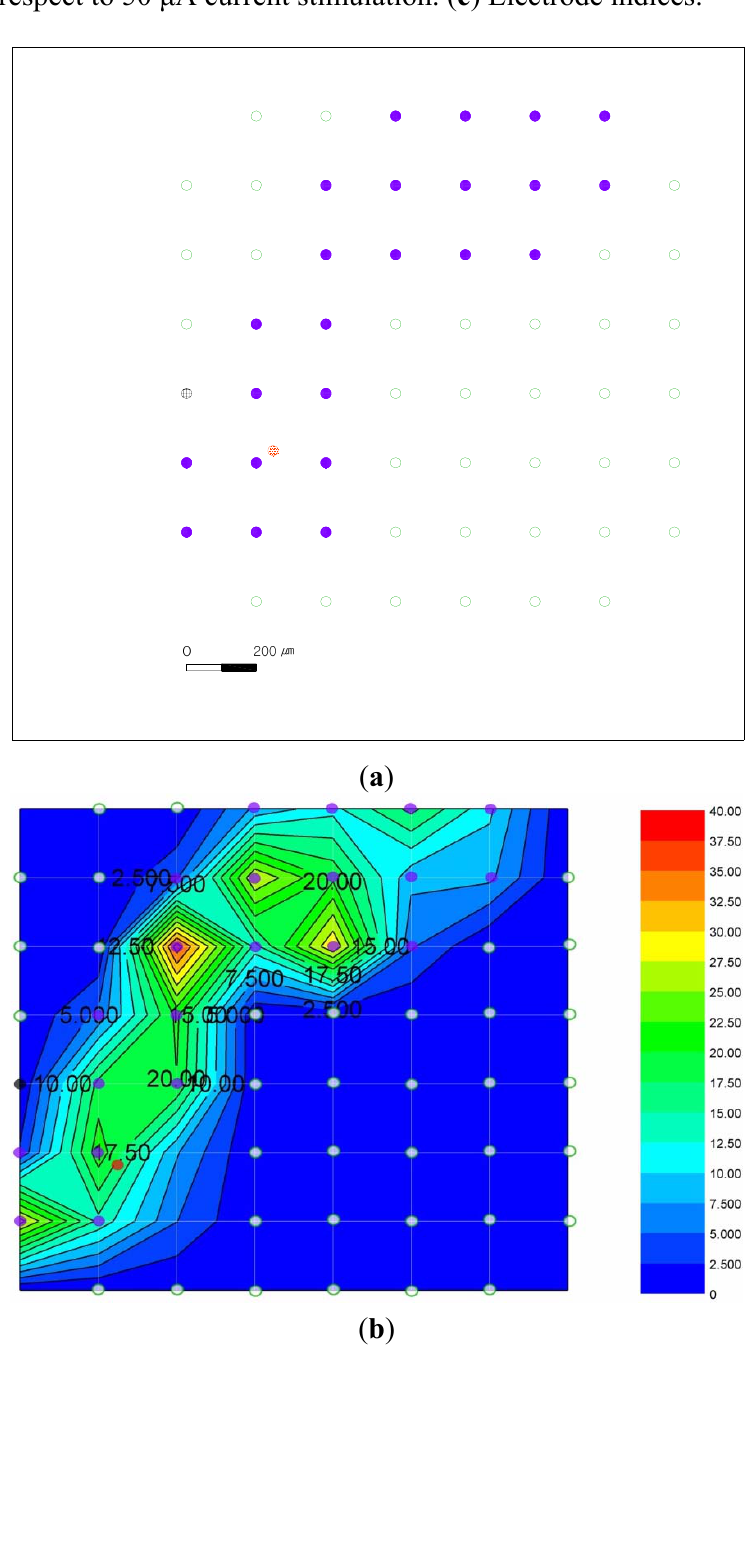
Figure 6. The monopolar stimulation results. ( a ) The spatial response map of the monopolar stimulation. ( b ) The contour diagram of the monopolar stimulation. The numbers on the contour diagram are the evoked RGC spike numbers with respect to 50 μ A current stimulation. ( c ) The spatial response map of the bipolar stimulation ( d ) The contour diagram of the bipolar stimulation. The numbers on the contour diagram are the evoked RGC spike numbers with respect to 50 μ A current stimulation. ( e ) Electrode